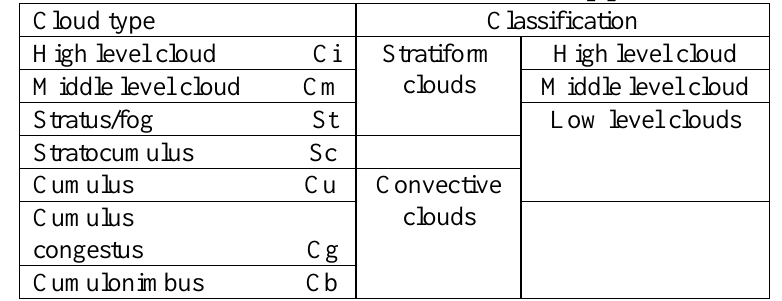
Table 1: The classification of clouds [3].